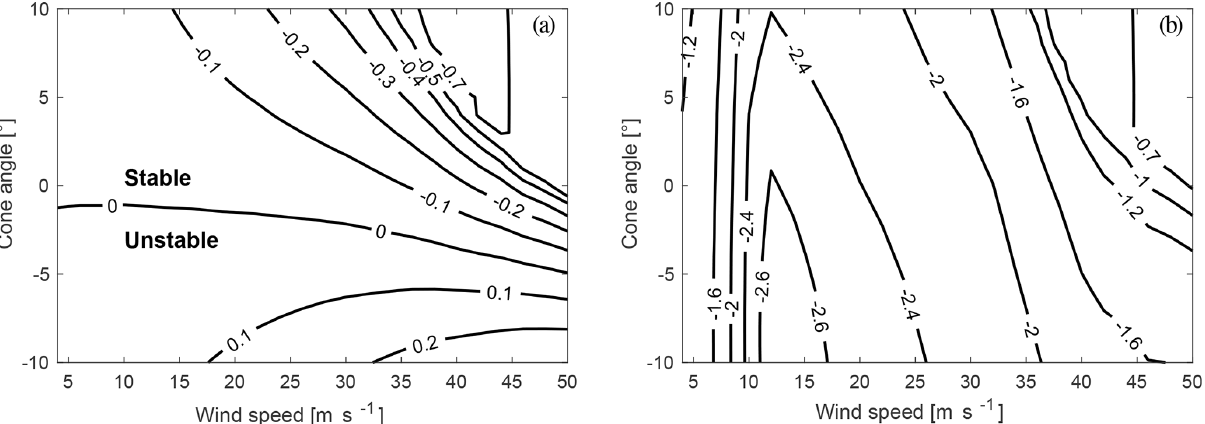
Figure 11. Real part of the first (a) and second (b) eigenvalue of the yaw mode for a variation in cone angle and wind speed from the 2-DOF model.